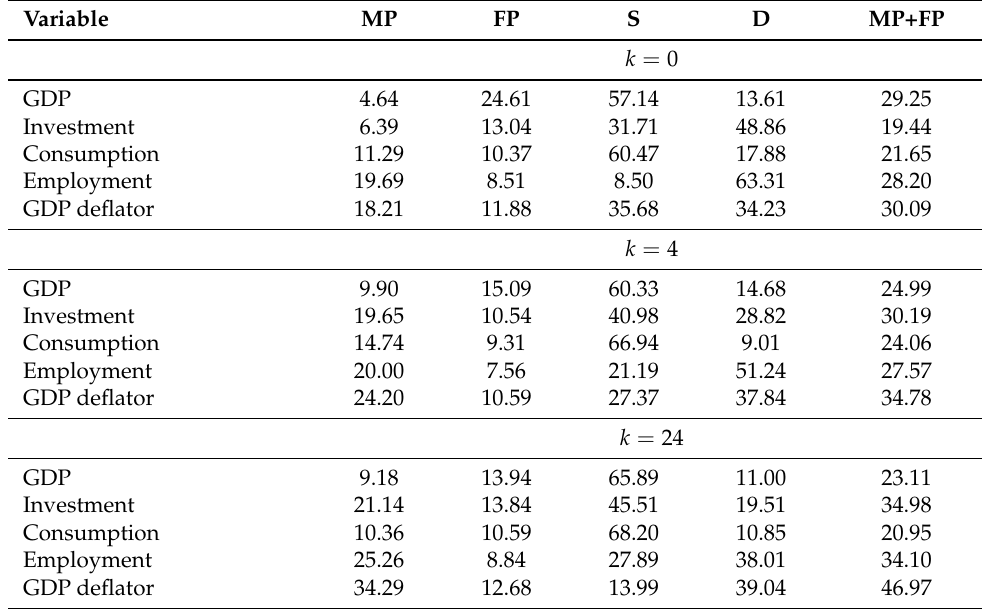
Table 2. Forecast error variance decomposition at different